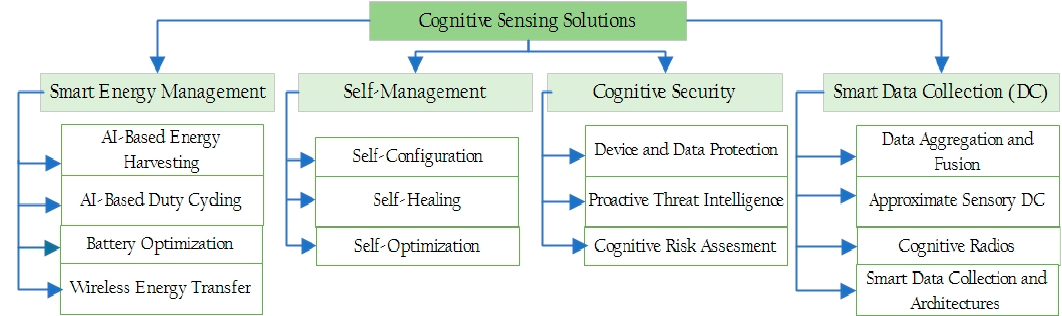
Figure 2. Classification of various cognitive sensing solutions .